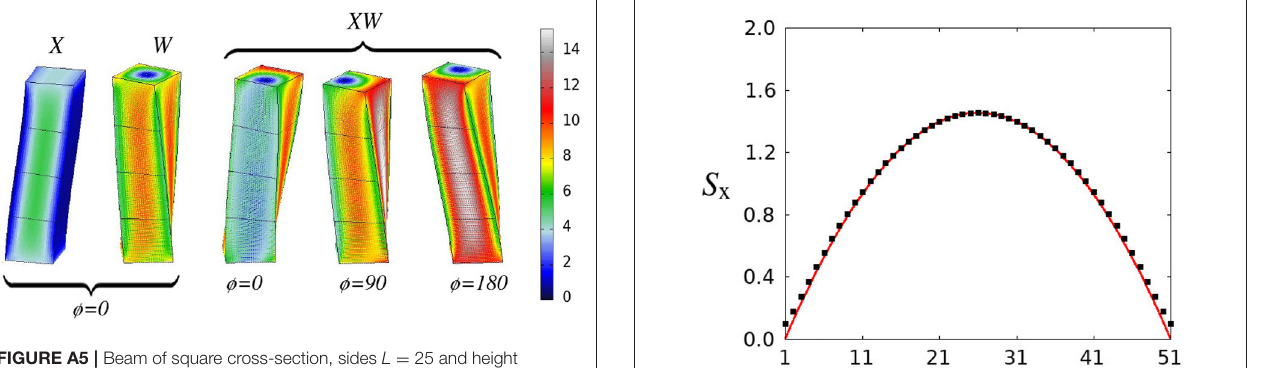
FIGURE A5 | Beam of square cross-section, sides L = 25 and height H = 101, made up of discrete elements. The structure has been subjected to shear ( X ), torsion ( W ) and both these loadings combined ( XW ). Here, φ 6= 0 is a counter-clockwise rotation of the structure. Hence φ = 90 has turned the side corresponding to Z V 090 toward the viewer. P